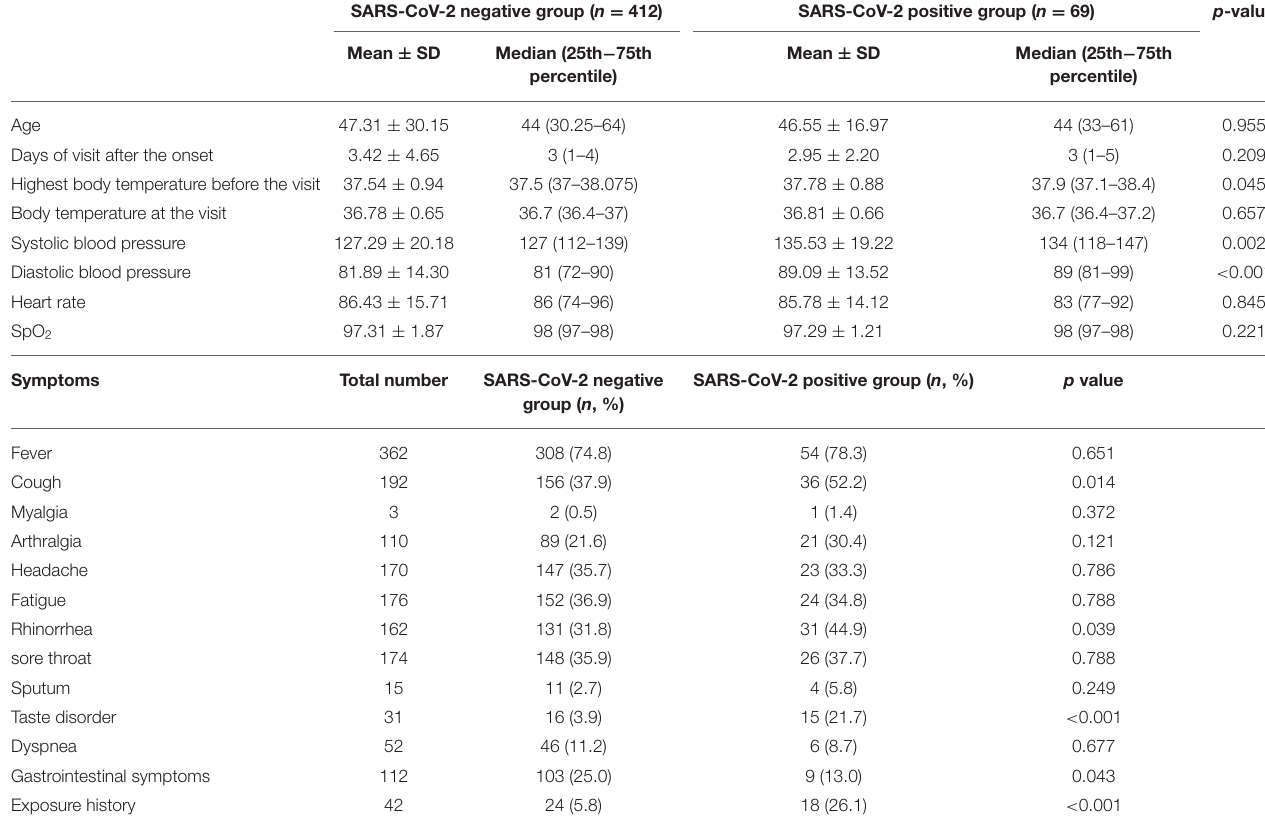
TABLE 1 | Patient characteristics, vital signs, and symptoms upon presentation to the outpatient